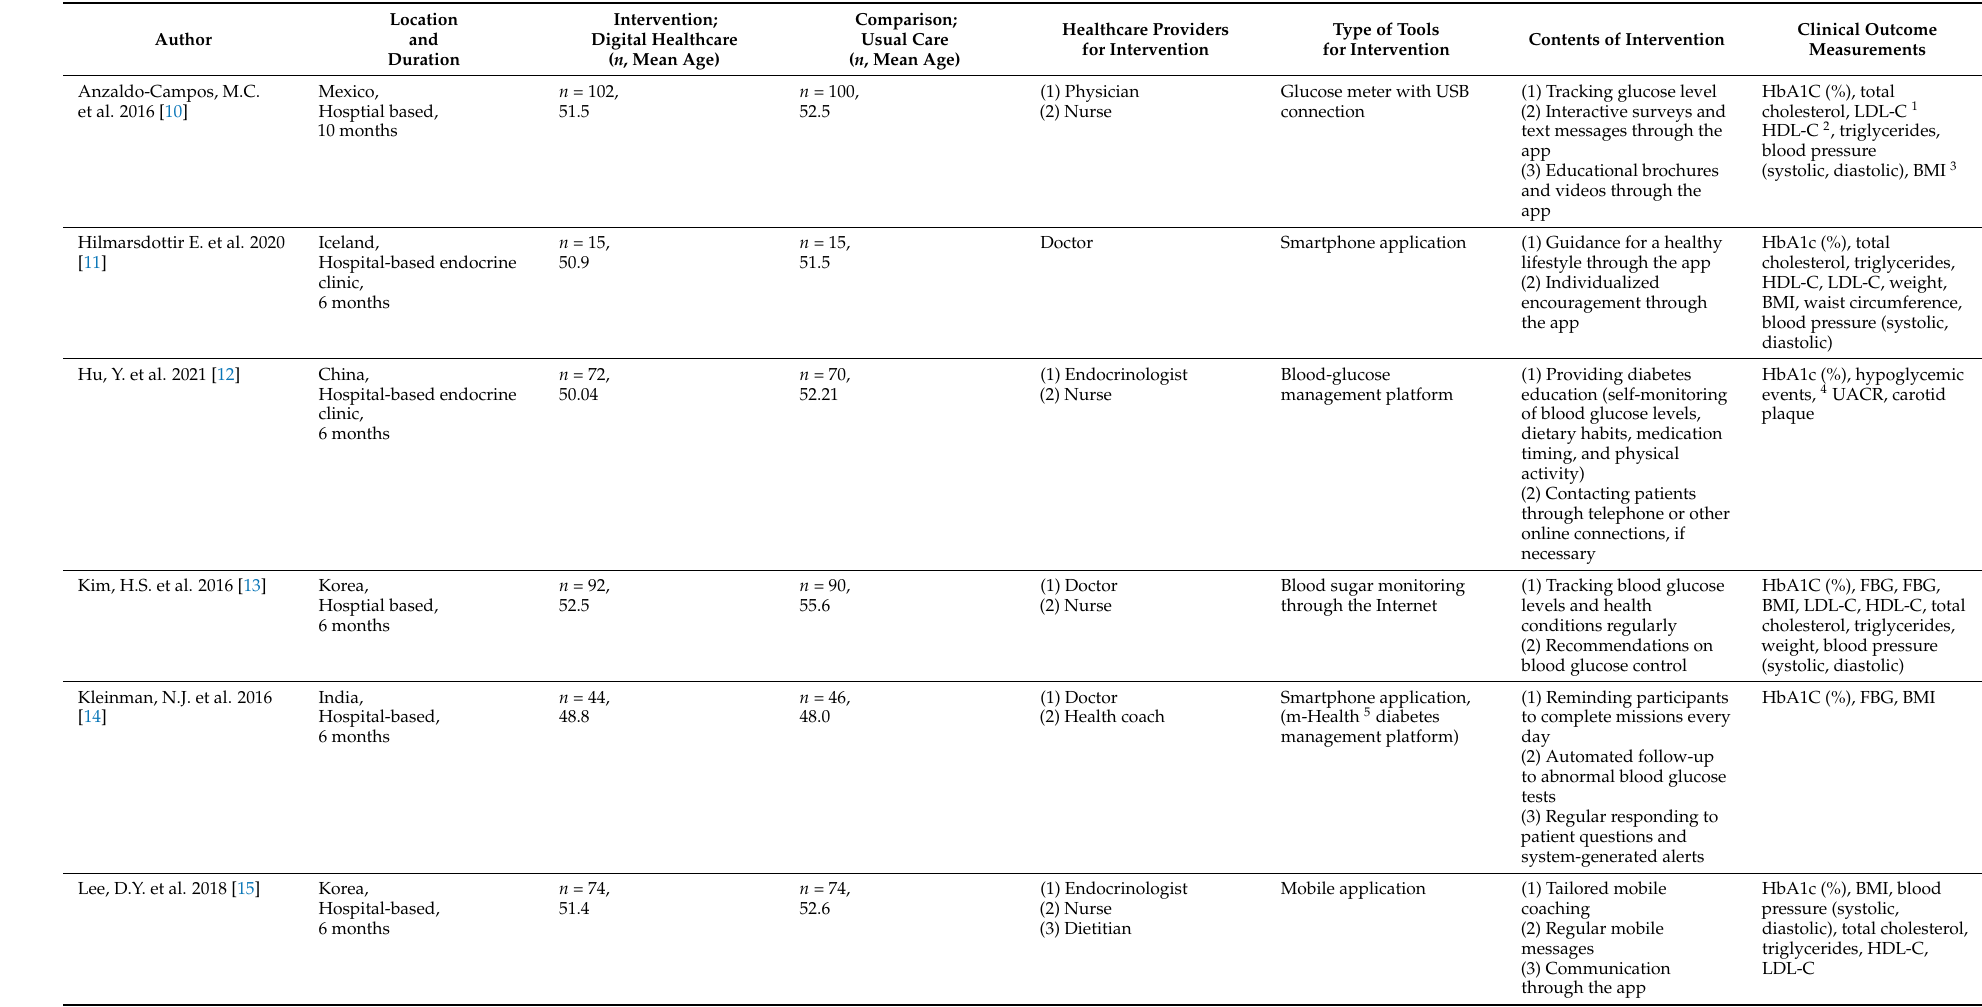
Table 1. Baseline characteristics of included studies evaluating digital healthcare technology interventions by healthcare